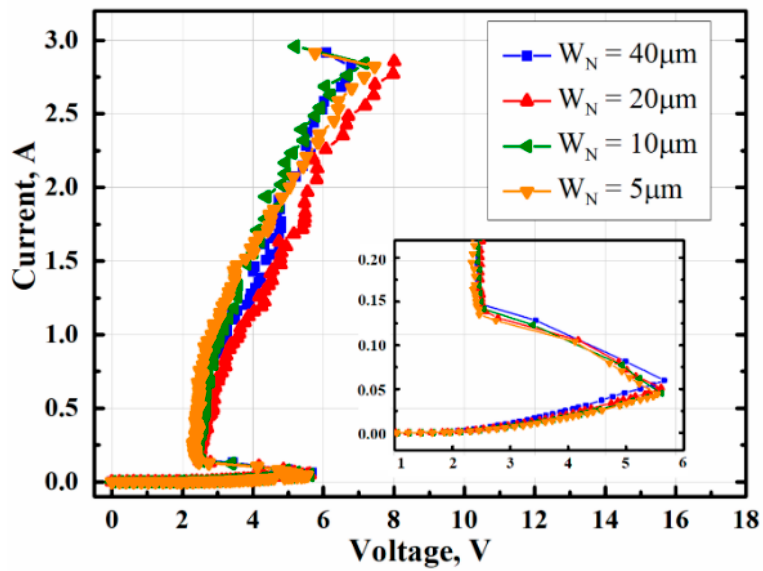
Figure 6. TLP test results of MTSCRs with different widths of the ENMOS transistors (W N ). In modern technology, the epitaxy is getting thinner and thinner, and the sheet resis- tance of WELL is also increasing with it. Thus, the impact of D1 (shown in Figure 1a) on well resistance will be significant. Figure 7 presents the TLP test results of MTSCRs with various D1. As D1 was increased from 0.5 µ m to 4.0 µ m, the V t1 decreased from 6.92 V to 5.03 V. The trigger current also decreased from 892 mA to 467 mA, while the I t2 increased from 2.72 A to 2.97 A. This phenomenon is related to the current distribution among the current within the MTSCR. The increased D1 means larger equivalent resistance of